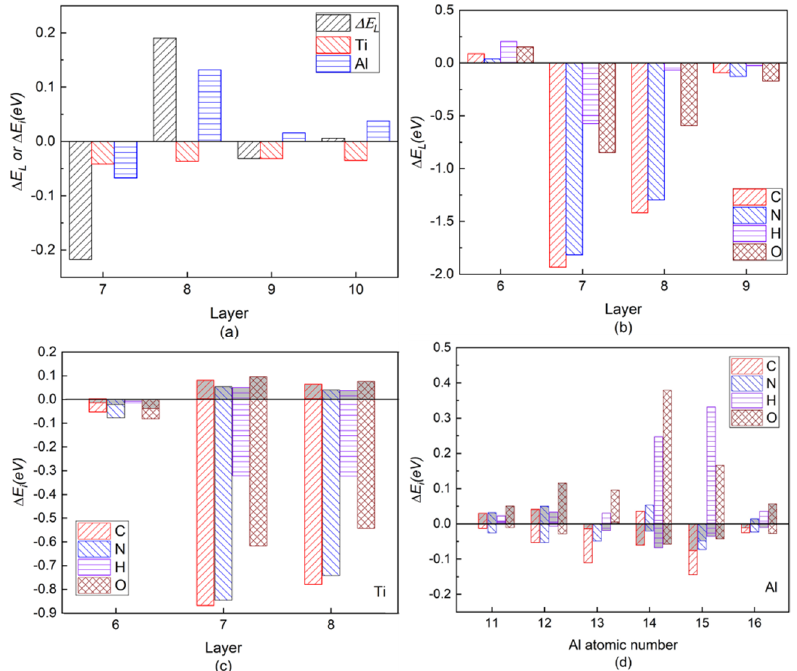
Figure 3. (Color on line.) ( a ) Local energy of pure twin. Symbol “ ∆ E L ” represents the layer energy (including two Ti and two Al atoms), and symbol “Ti” and symbol “Al” represent the atomic energy of a single Ti atom and a single Al atom in the corresponding atomic layer, respectively. ( b ) Layer energy from Layer6 to Layer9 in the presence of interstitial atom C, N, H, and O in the twin model compared to Ti and Al atomic energies in pure γ-TiAl without twin structure. ( c ) Single Ti atomic energy compared to Ti atomic energy in pure twin model. ( d ) Single Al atomic energy compared to Al atomic energy in pure twin model in layers from Layer6 to Layer8. The gray part in each histogram represents SAE, whereas the residual part represents CAE caused by C/N/H/O insertion.